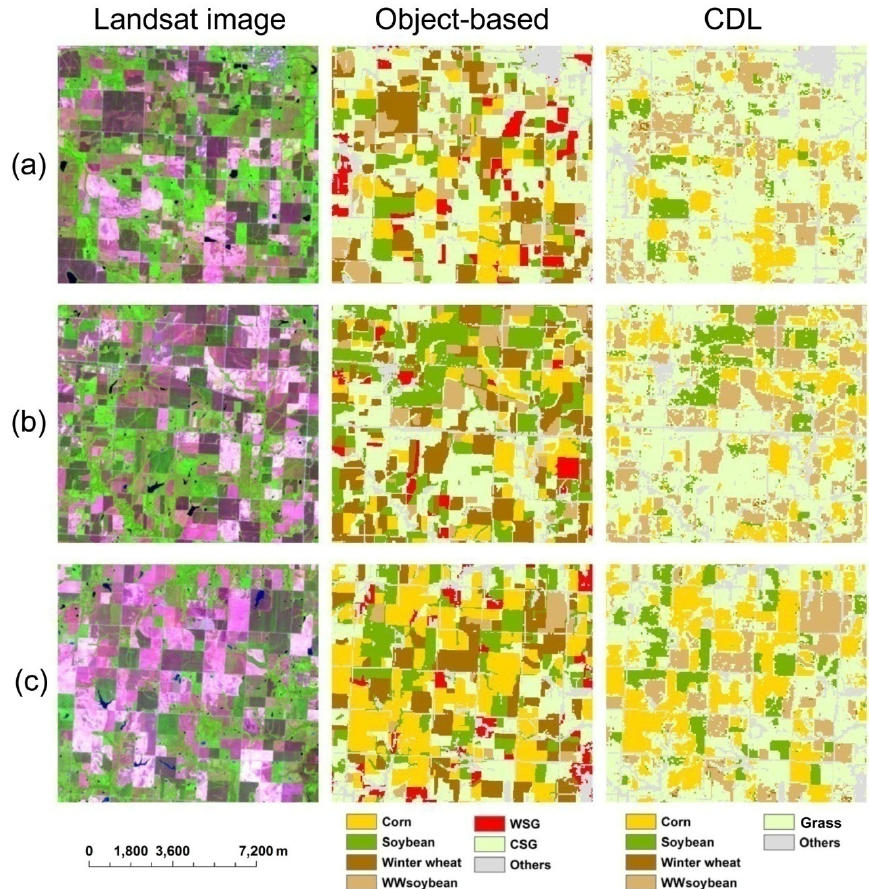
Figure 9. Demonstrative comparison between our classification and CDL products in three subsets ( a ), ( b ) and ( c ). Column (1) the color composite display R (band 5) G (band 4) B (band 3) of Landsat 5 image in DOY 140 of 2007, column (2) object-based classification map, and column (3) CDL map.